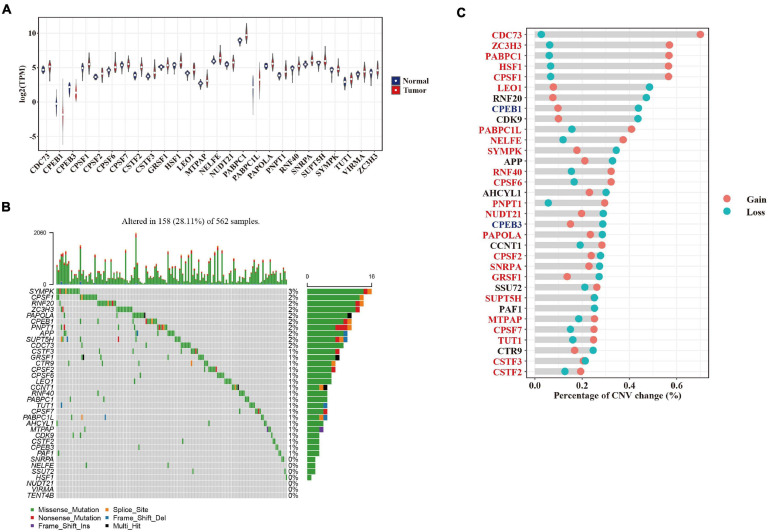
Genetic and expression alterations in APA regulators. (A) Violin plot showing the expression of 26 significantly dysregulated APA factors between tumor (red) and adjacent normal (blue) samples in the TCGA cohort. (B) The mutation landscape of 35 APA regulators in the TCGA cohort. Top panel shows the tumor mutation rate of each patient. Bottom panel indicates the mutation frequency of individual regulators. Mutation types are shown in the legend at the bottom. (C) The CNV variation frequency of APA regulators in the TCGA cohort. Gain and loss of CNV are indicated by red and blue dots, respectively. Upregulated and downregulated APA factors are colored in red and blue.